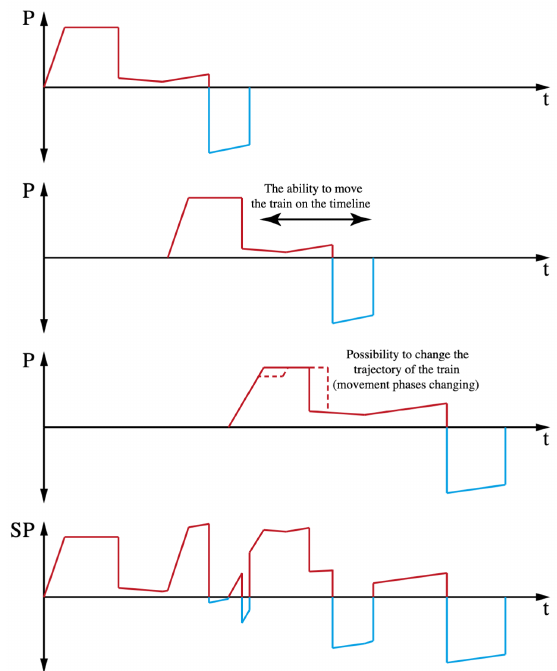
Figure 2. The gist of the issue.